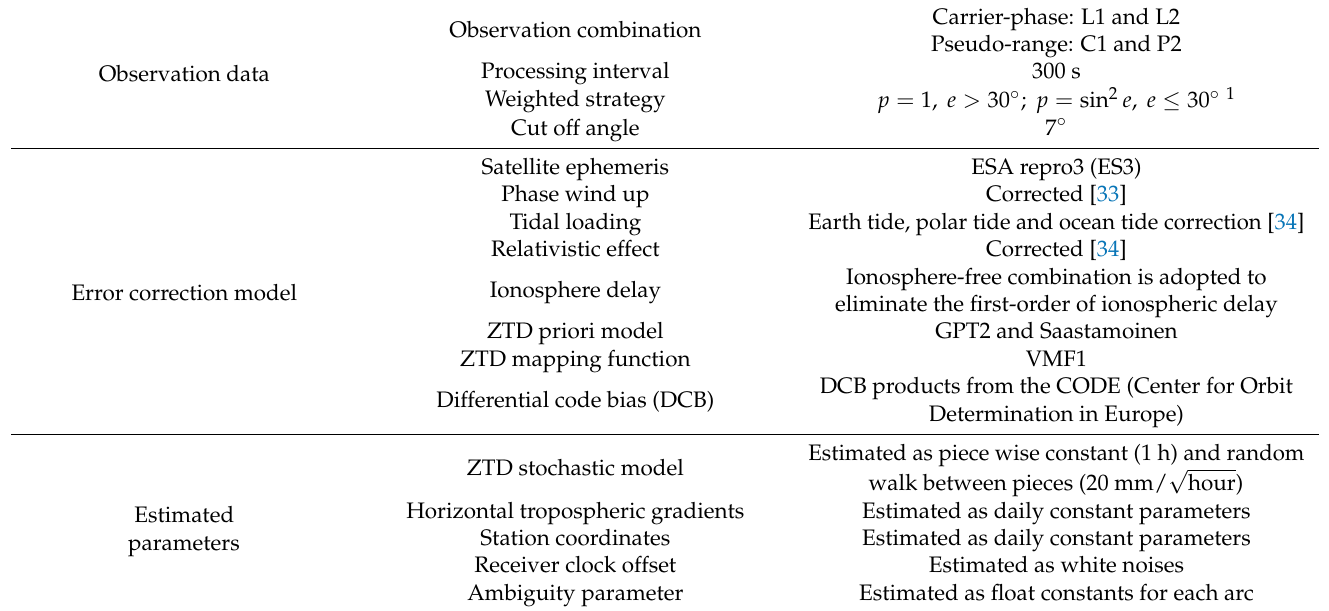
Table 1. GPS data descriptions and PPP processing